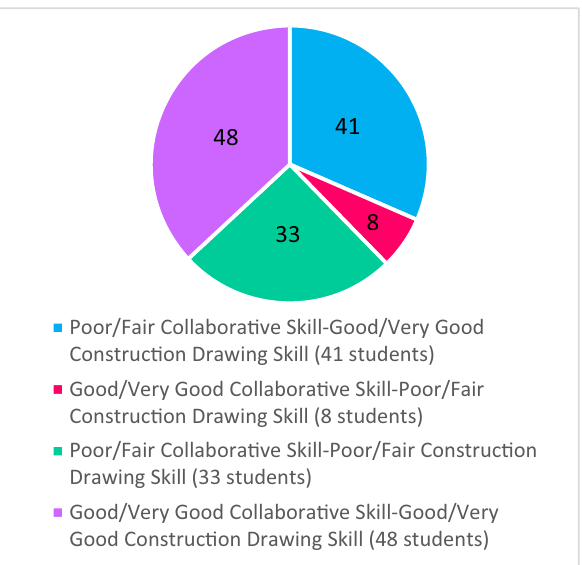
Figure 3: Students ’ skill characteristics related to the level of collaborative skill and construction drawing skill